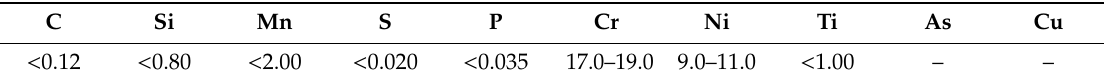
Table 1. Chemical composition of a specimen, wt